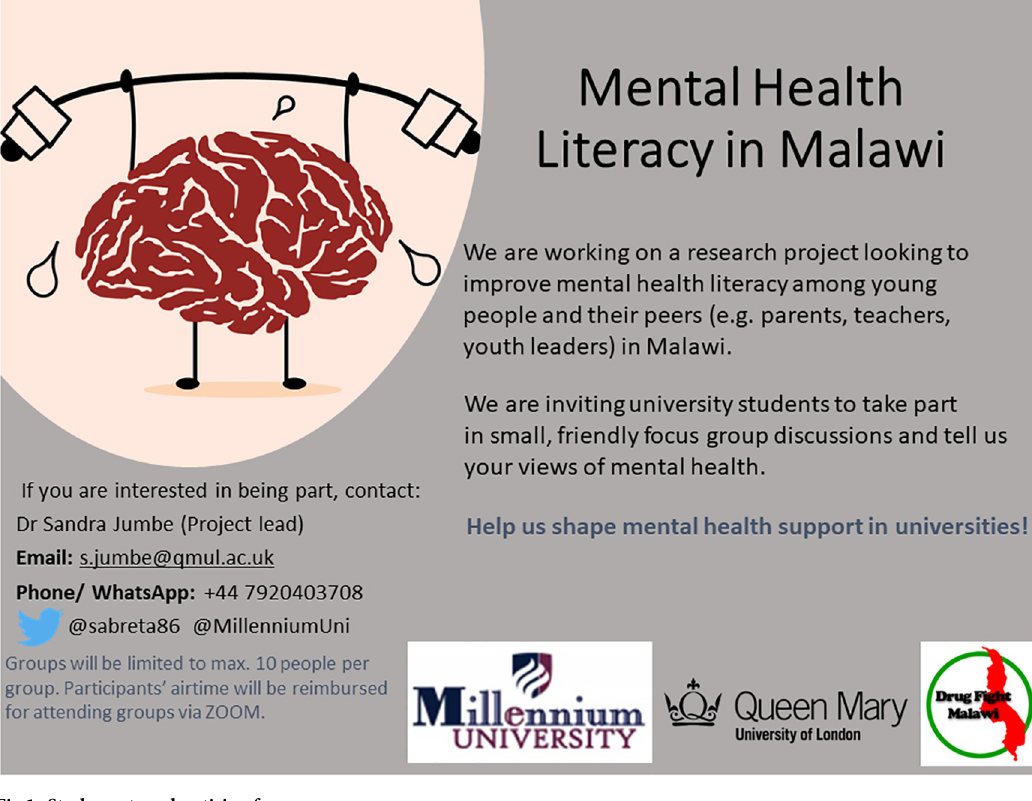
Fig 1. Study poster advertising focus